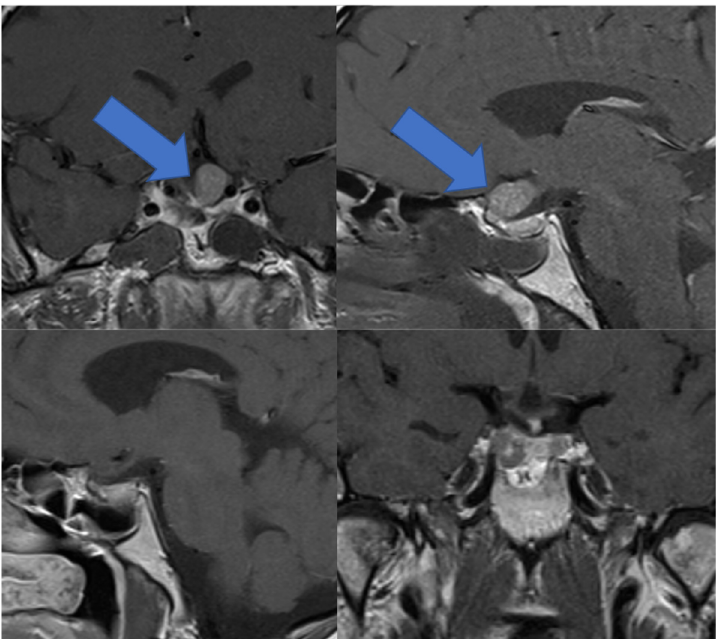
Figure 4. Intraoperative MRI depicting adenoma remnant and follow-up MRI 3 months after sur- gery showing decompressed chiasm and fat graft used for reconstruction of the sella. showing decompressed chiasm and fat graft used for reconstruction of the